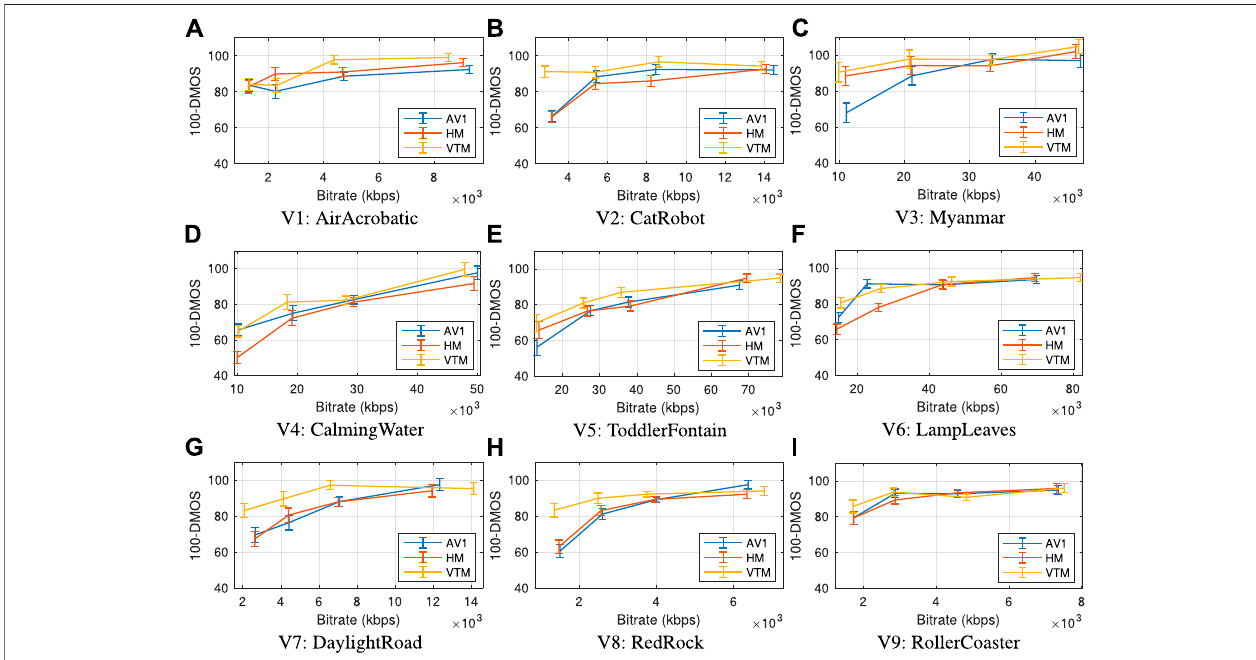
FIGURE 4 | The DMOS-Rate curves for all sequences (A – I) of Resolution Group A and all three codecs along with the standard error bars after compensating for subject bias, as described in Recommendation P.913 (2021).